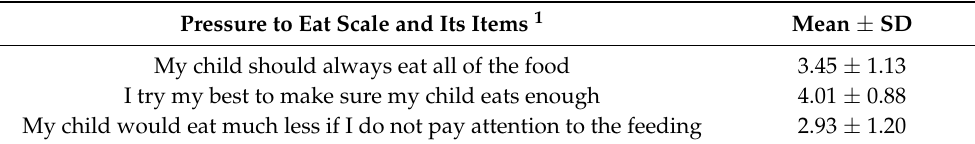
Table 4. Descriptive statistics of pressure to eat scale and its items ( n = 630).